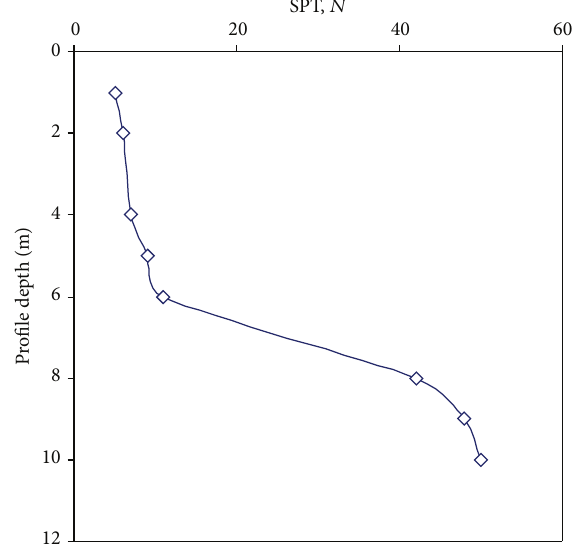
Figure 3: Unconfined shear strength distribution of subsoil.